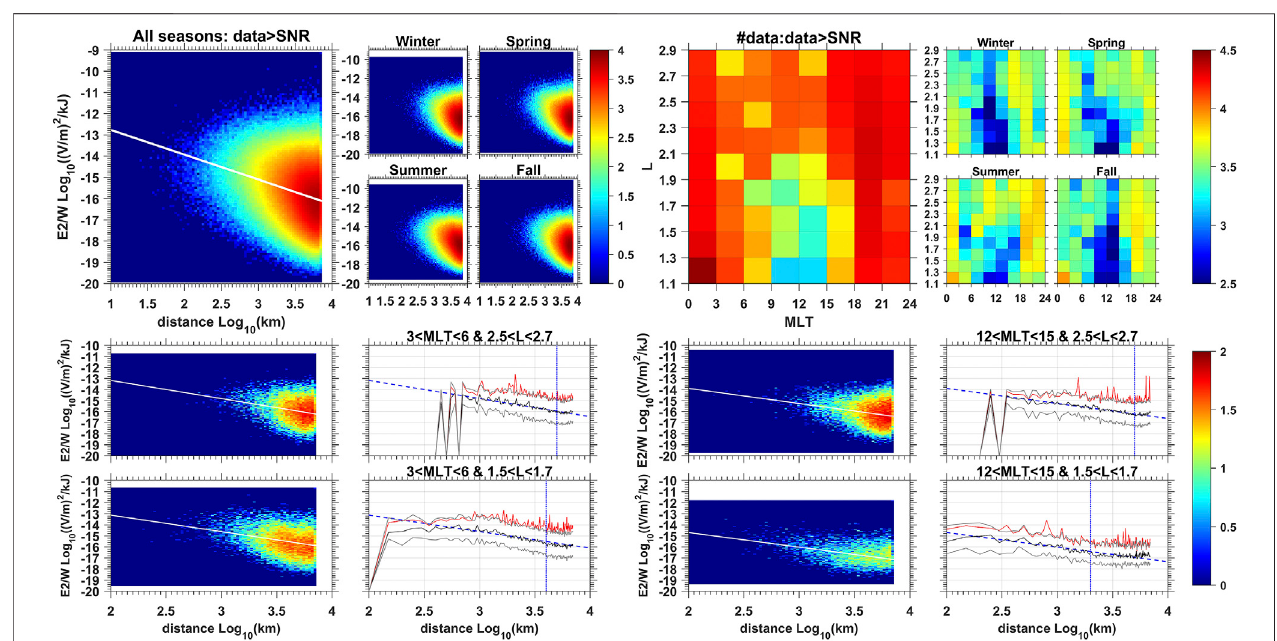
FIGURE 1 | (top left) Statistics of LGW Electric power (V/m) 2 (in log10 of number of events), rescaled by WWLLN lightning energy (kJ) and plotted versus distance between the lightning location (from WWLLN) and the spacecraft for the full database of Van Allen Probe A and B mission (2012 – 2019), with full distribution and distribution per season. The distribution is spread over many orders of magnitude due to the different behaviors in (L, MLT) (top right) Number of events (in log10) sorted by(L,MLT)and(season,L,MLT)(bottom)Samestatistics(inlog10)astopleftbutlimitedto(left)anightbinofatMLT (cid:1) [3,6]andL (cid:1) [2.5,2.7]and[1.5,1.7]and(right) a day bin at MLT (cid:1) [12,15] and L (cid:1) [2.5,2.7] and [1.5,1.7]. White line plots represent linear regression (left bottom panels only). Line plots represent (black) the median, (grey)theupper(84%)andlower(16%)quartilesde fi ningonesigma,(red)themean,(blue)thelinearregressionwhichequatesthemedian.We fi ndthemeanequatesthe median plus one sigma. The vertical blue dashed line indicates the maximal distance used for the fi ts given in Table 1 .